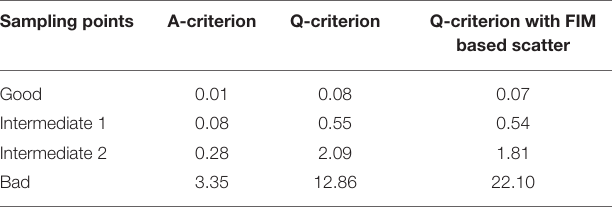
TABLE 4 | Comparison of different optimization criteria for different sampling points.